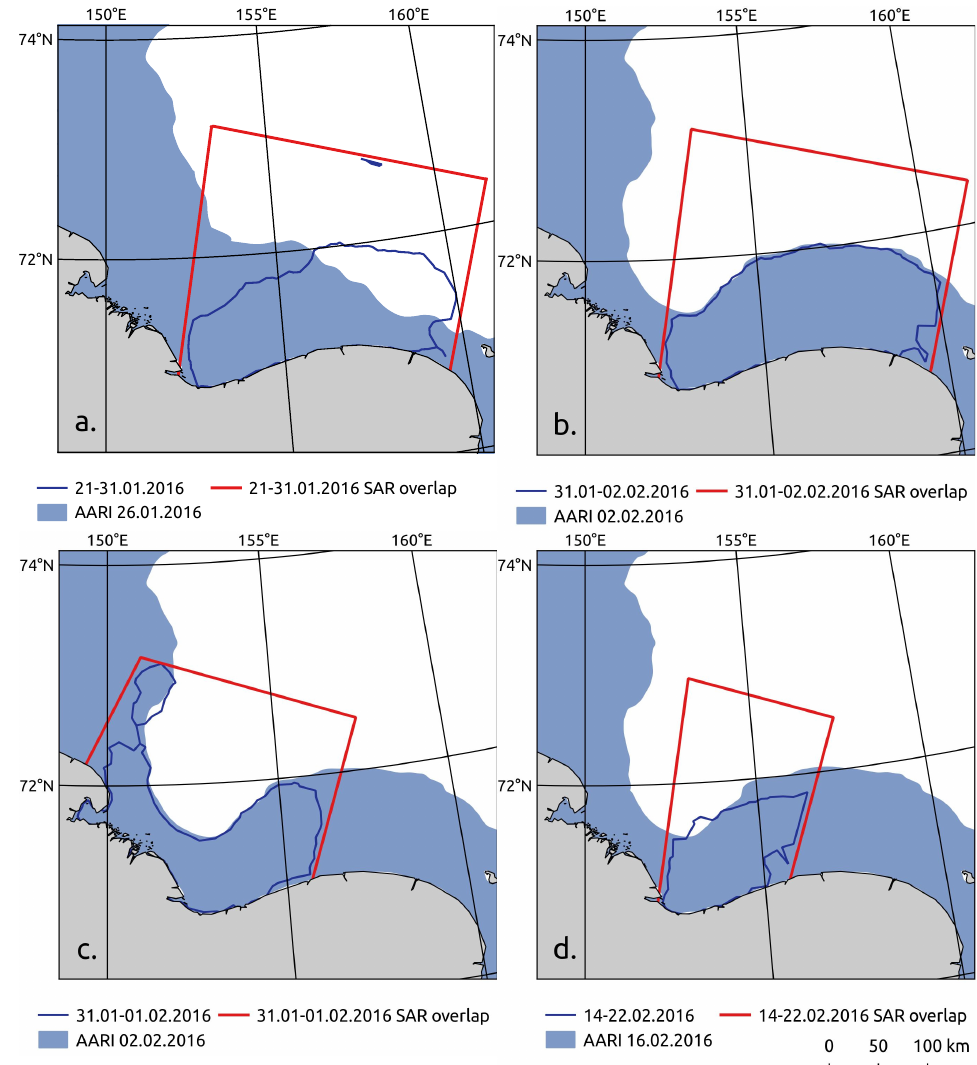
Figure 6. The fast ice polygons derived from Sentinel-1 data and the corresponding AARI fast ice zones over the East Siberian Sea region for 21–31 January 2016 ( a ), 31 January–2 February 2016 ( b ), 31 January–1 February 2016 ( c ), 14–22 February 2016 ( d ). The dates in the legend correspond to the timing of the first and second SAR images and the issue date of the AARI ice